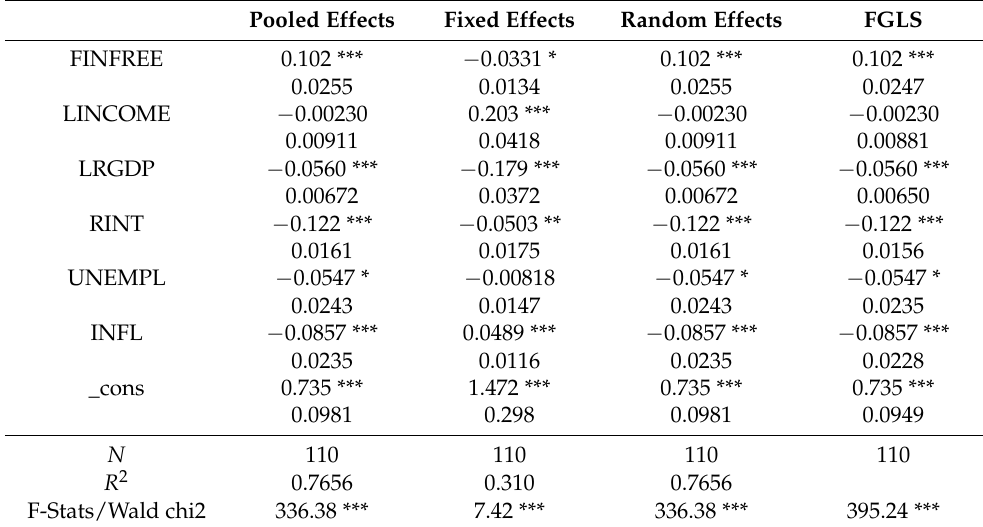
Table 5. Determinants of life insurance demand as measured by insurance